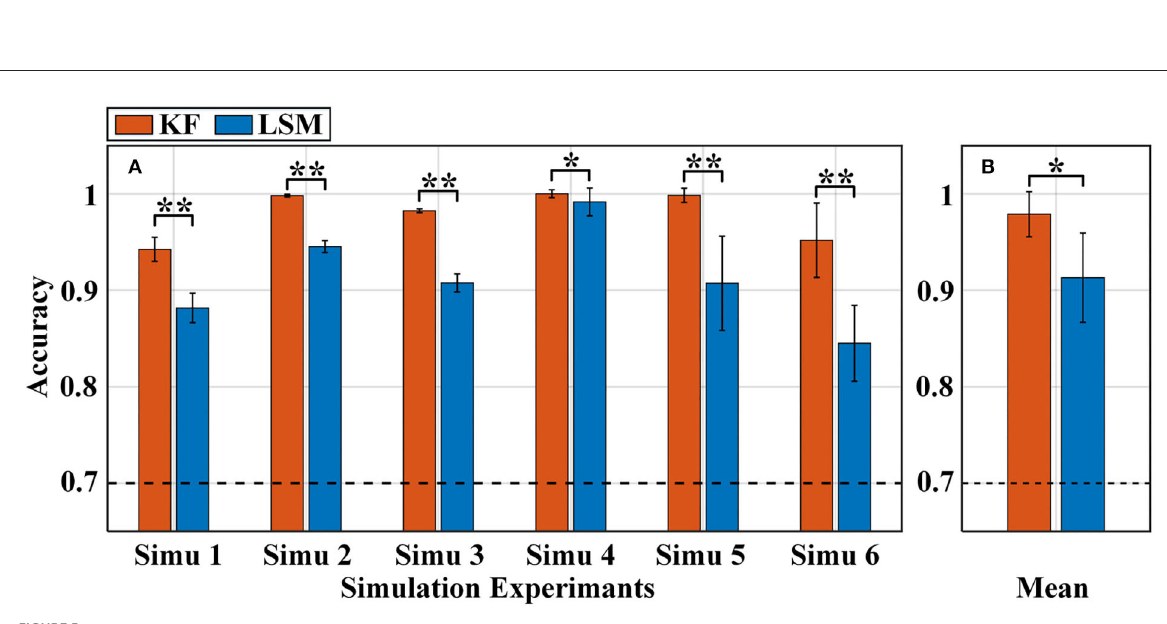
FIGURE5 Classification accuracy of the a-GMM classifier in all simulations was based on the level feature extracted by KF and LSM methods. (A) Average accuracy of each simulated experiment, (B) average accuracy across all simulated experiments. The black dashed line indicates 70% accuracy of effective binary BCI communication. Error bars indicate the standard deviations, *Represents the significant difference, * p < 0.01 and ** p <